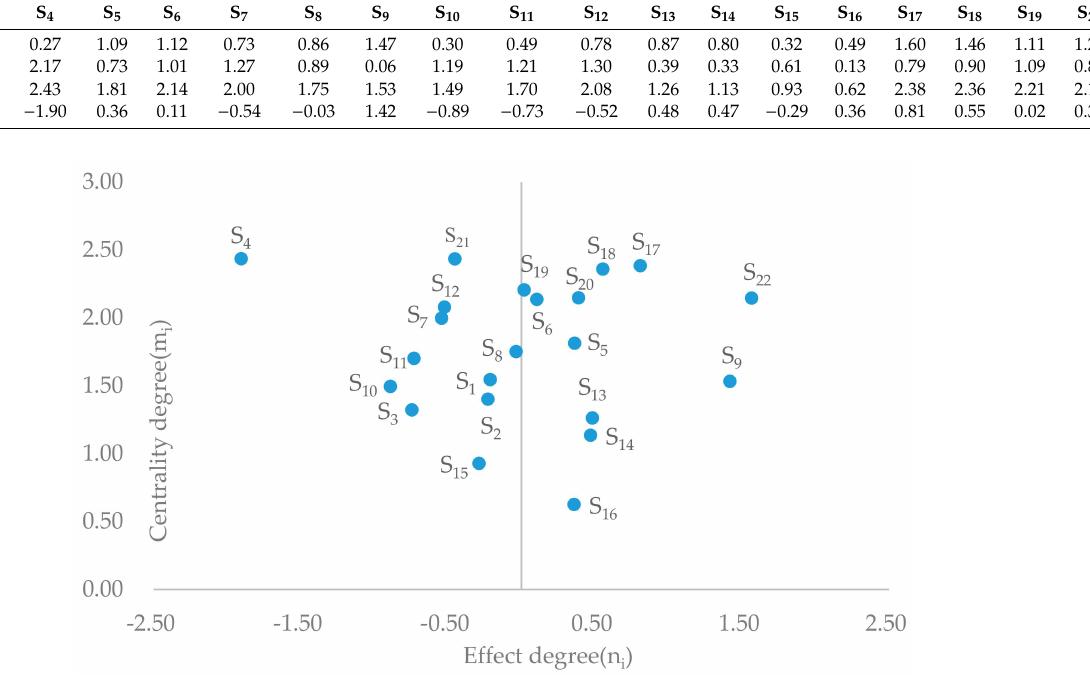
Figure 2. The cause-and-e ff ect relation